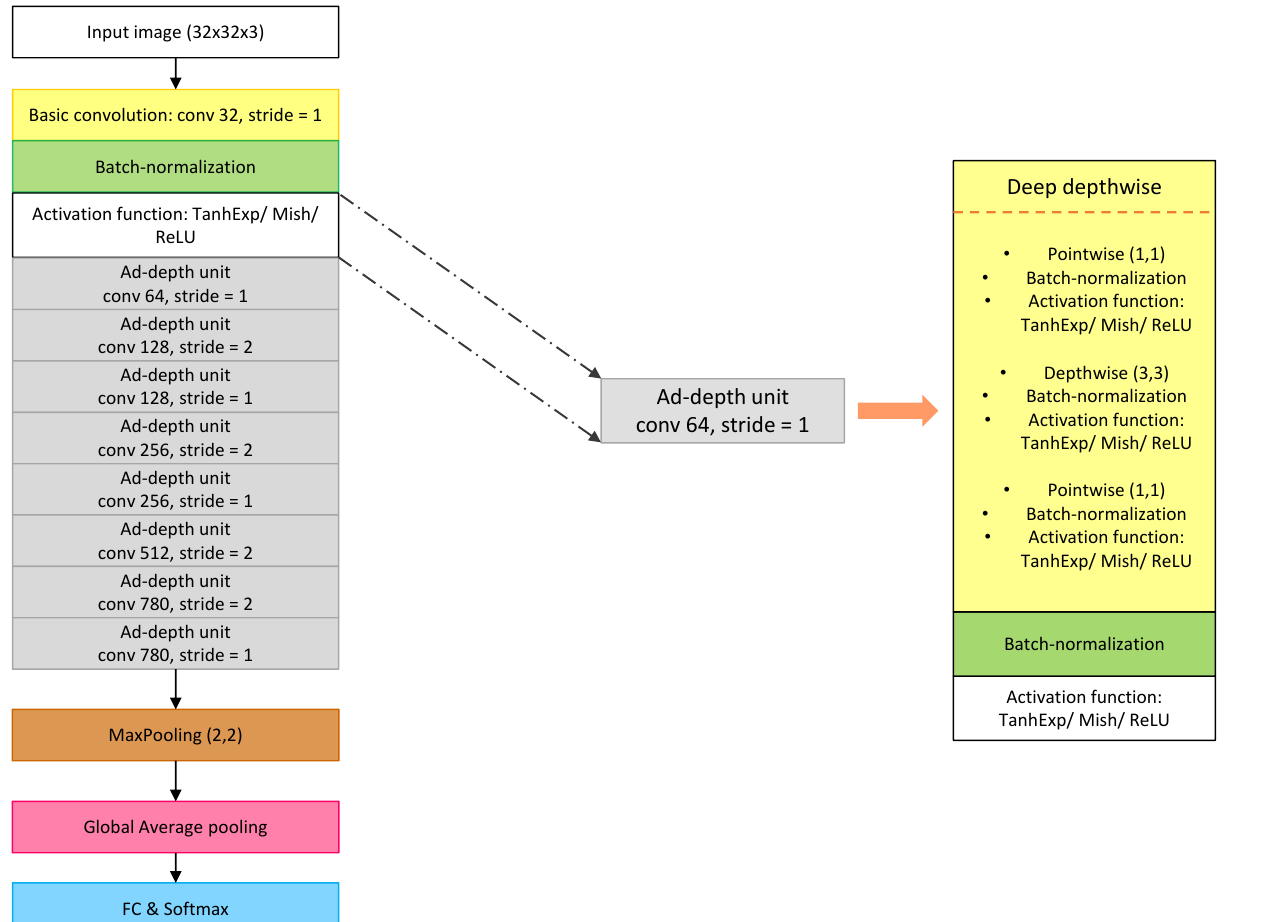
Figure 8. Architecture of the Ad-MobileNet model with the structure of the Ad-depth